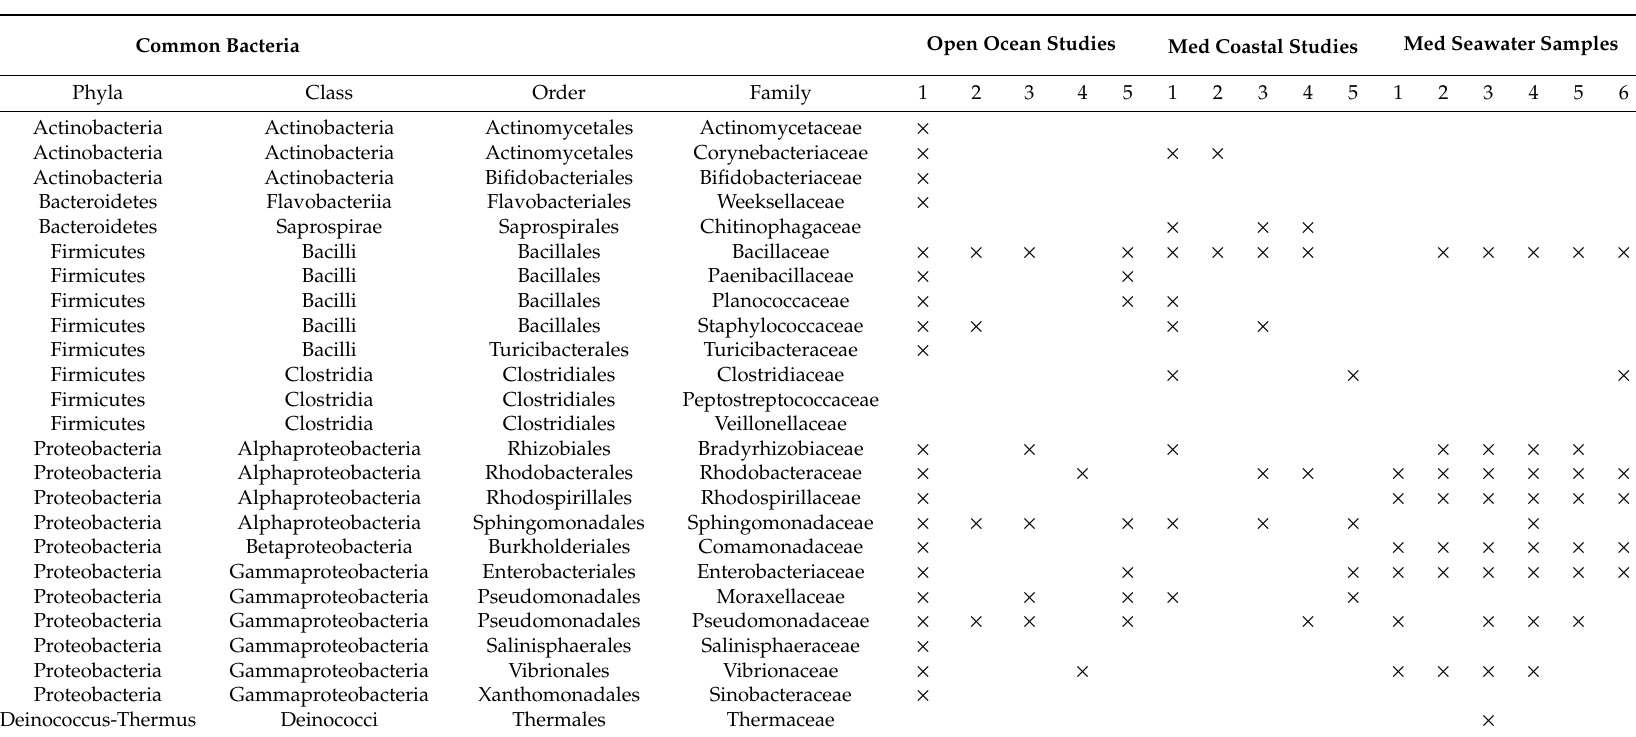
Table 2. ‘Common’ organisms found over the Mediterranean Sea in this study compared to five studies focusing on marine aerosols [1,8,38,55,56], five studies focusing on coastal aerosols [3,31,32,57,58], and six samples from one study focusing on Mediterranean surface seawater [59]. Columns under open ocean studies refer to references [1,8,38,55,56], columns under Mediterranean coastal studies refer to references [3,31,32,57,58], and columns under Mediterranean seawater samples refer to six samples from reference